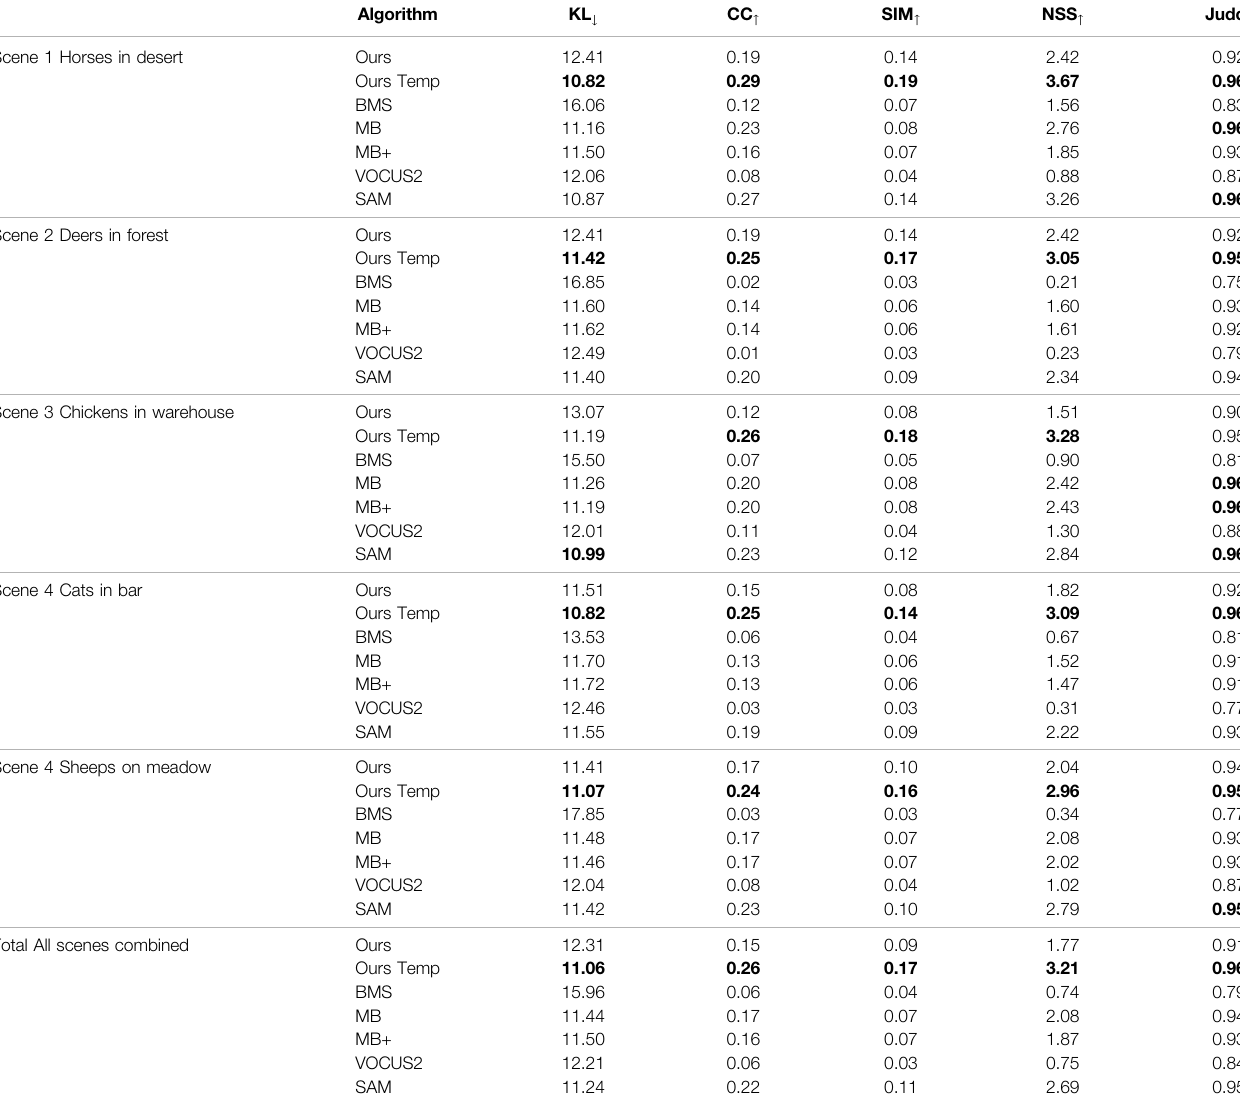
TABLE 1| Predictioncapabilityofthegazeofthecurrent user onthe DGaze dataset (Huet al.,2020)withourgaze mappingapproach, eitherbyincluding the previousgaze points of the current user (Ours Temp), or by ignoring those and focusing on gaze points from other users only (Ours).